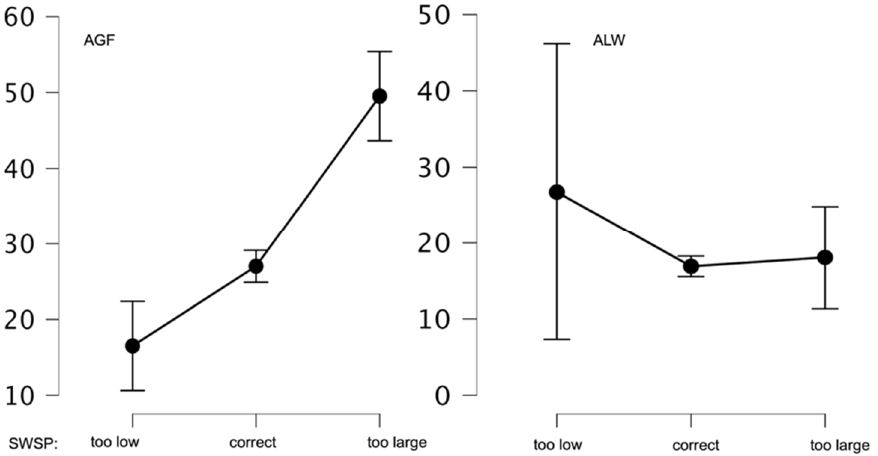
Figure 4. Mean AGF and ALF values of SWSP in the group with normal BMI.